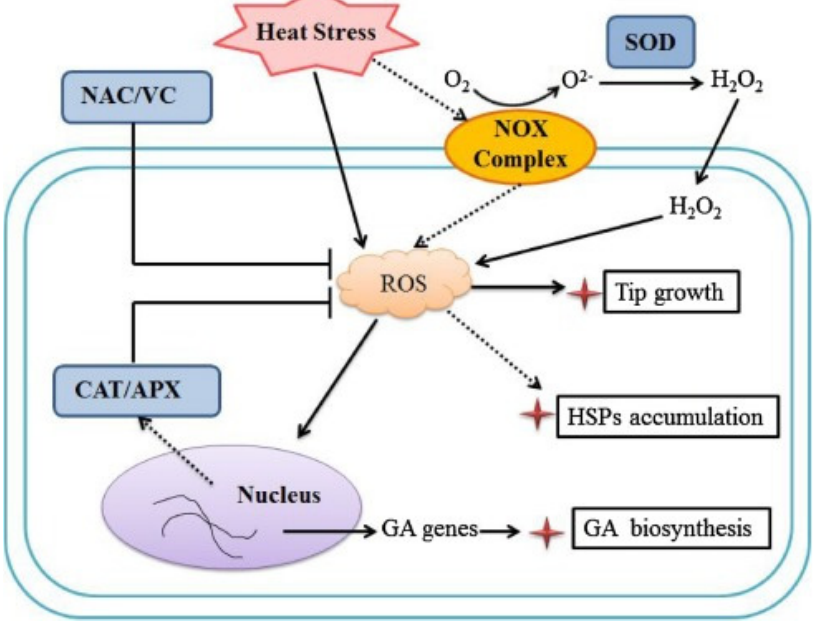
Figure 1. Schematic representation showing the relationship between HS and ROS [121]. GA: ganoderic acid, HSPs: heat shock proteins, ROS: reactive oxygen species, SOD: superoxide dismutase, CAT: catalase, NAC: N-acetyl-l-cysteine, VC: ascorbic acid, APX: Ascorbate Peroxidase.8.1. Lipid Oxidation.